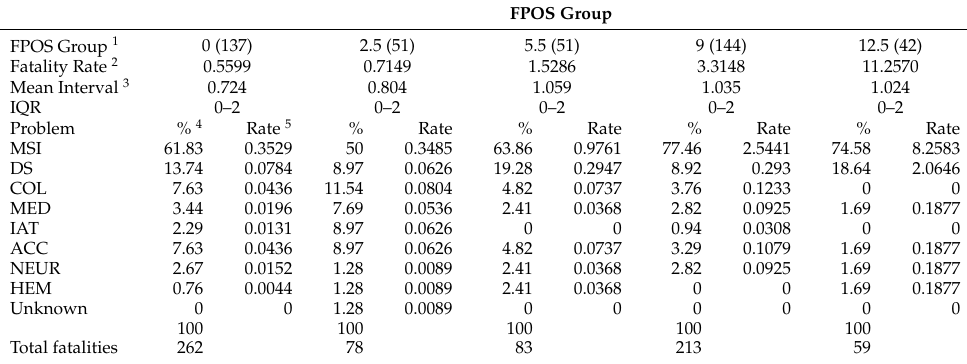
Table 6. Fatality rates, interval from race work-event to fatality and distribution of consolidated presenting problems for finish position groups for thoroughbred racehorse fatalities in Ontario racing from